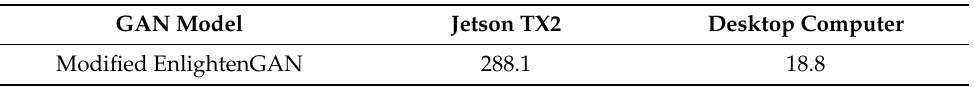
Table 20. Comparison of desktop computer and Jetson TX2 processing times by EnlightenGAN (unit: ms).